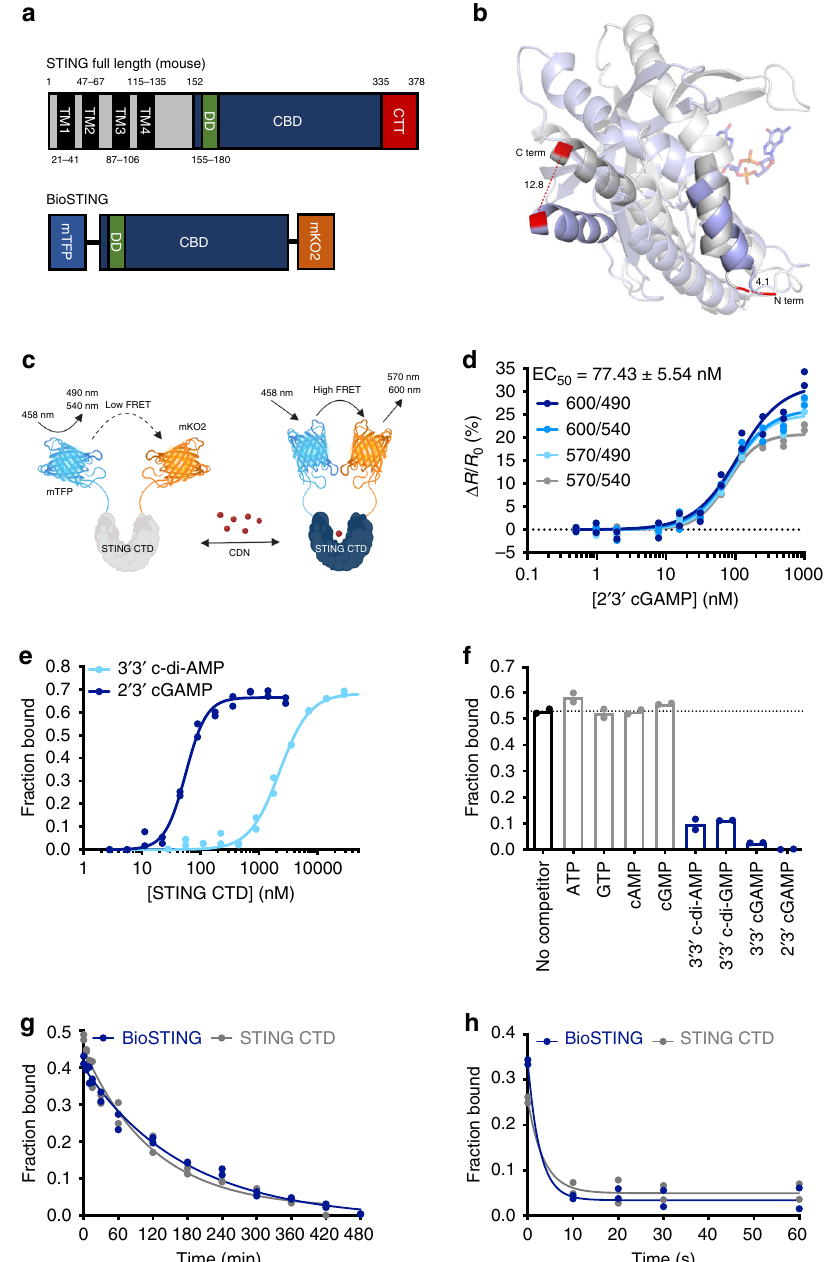
Fig. 1 BioSTING design and optimization. a Schematic representation of full-length STING (top) and BioSTING with additional GGSGG linker between mTFP and STING-CTD (bottom). Abbreviations are de fi ned as follows: TM (transmembrane region), DD (dimerization domain), CBD (CDN binding domain), and CTT (C-terminal tail). b Overlay and structural alignment of human STING CTD in apo (blue) and c-di-GMP bound (gray) states (PDB 4F5E and 4F5D, respectively). Only a single monomer, which exhibits the largest structural rearrangement upon ligand binding, is shown. The N and C-terminal helices of the CTD are highlighted with the terminal residues in red and their associated displacement following ligand binding labeled in angstroms. c Model of the FRET increase which occurs upon CDN binding. Generated with Biorender.com. d Recombinant BioSTING FRET response to increasing concentrations of 2 ’ 3 ’ -cGAMP using 458 nm excitation and listed emission wavelengths. e DRaCALA radioactive nucleotide binding assay of BioSTING using ~1 nM [ 32 P] labeled 2 ’ 3 ’ -cGAMP and 3 ’ 3 ’ -c-di-AMP. Corresponding STING-CTD binding curve is Fig S1D. f DRaCALA binding analysis of BioSTING using ~1 nM [ 32 P] labeled 2 ’ 3 ’ -cGAMP in the presence of excess (500 µ M) unlabeled nucleotides. Corresponding STING-CTD competition is Fig S1e. g Time course of excess unlabeled 2 ’ 3 ’ -cGAMP competing off bound [ 32 P] labeled 2 ’ 3 ’ -cGAMP from BioSTING (blue) and STING-CTD (gray). h Time course of excess unlabeled 3 ’ 3 ’ -c-di-AMP competing off bound [ 32 P] labeled c-di-AMP from BioSTING (blue) and STING-CTD (gray). In panels g and h , BioSTING was pre-incubated with ~1 nM of [ 32 P] labeled CDNs for 10 min followed by the addition of 1 mM unlabeled 2 ’ 3 ’ -cGAMP ( g ) or 3 ’ 3 ’ -c-di-AMP ( h ). In all panels, individual data points of n = 2 biological replicates are